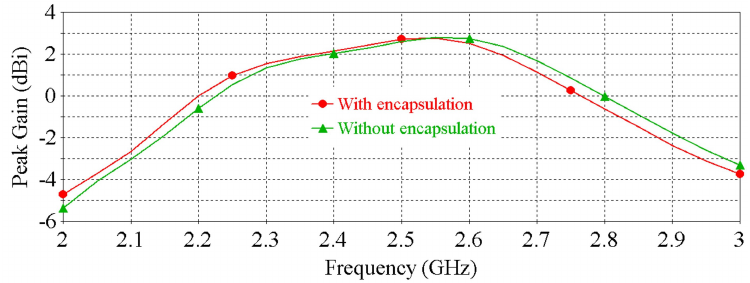
Figure 11. The effect of the PDMS encapsulation on the peak gain of the